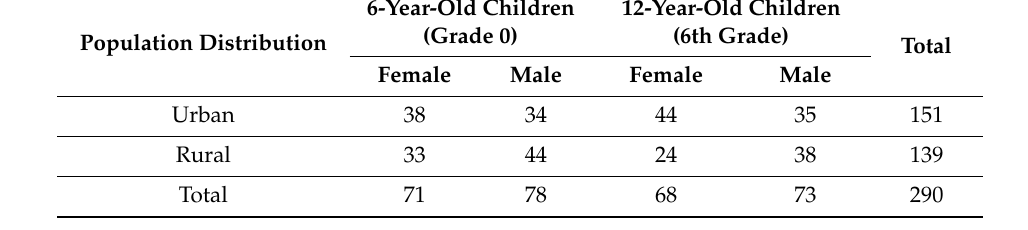
Table 1. Sample description according to gender, age, and residence distribution.